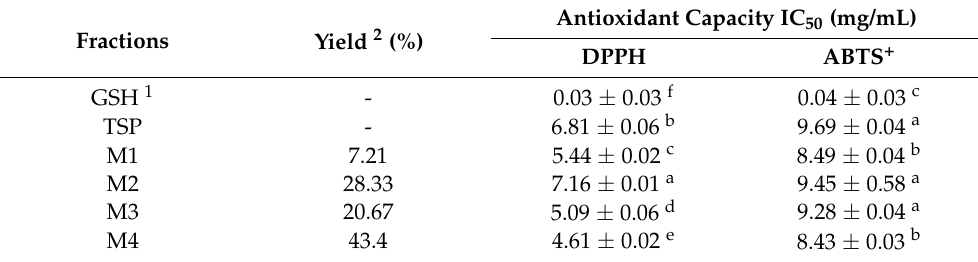
Table 1. Yield and antioxidant capacity (DPPH and ABTS assay) of GSH, TSP and ultrafiltration fractions.